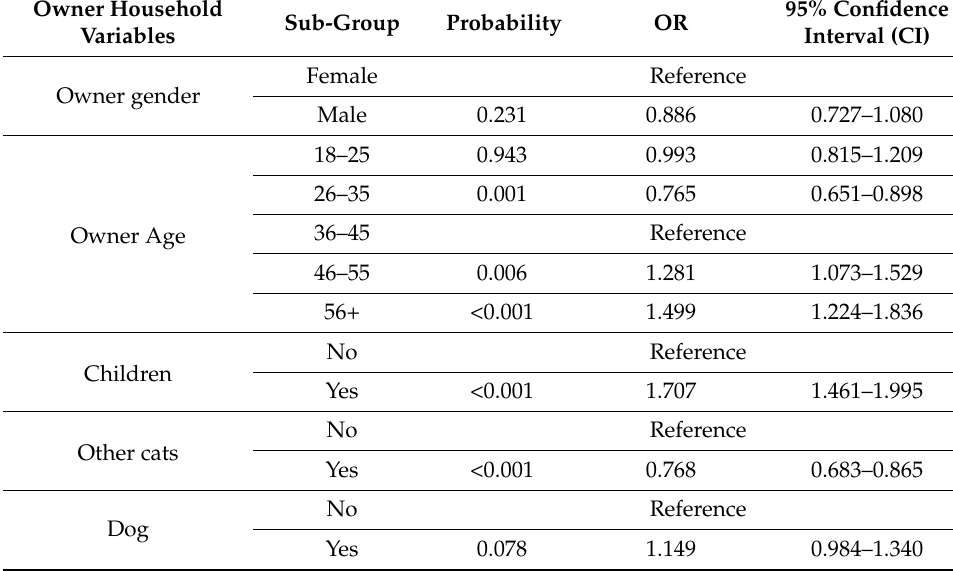
Table 3. Model 1, owner demographics: Results of 4909 owner household variables tested through binary logistic regression for their association with cat lifestyle. Owners with increased odds of providing outdoor access are indicated by an odds ratio (OR) greater than one, whilst an OR lower than one indicates owners with increased odds of keeping cats as